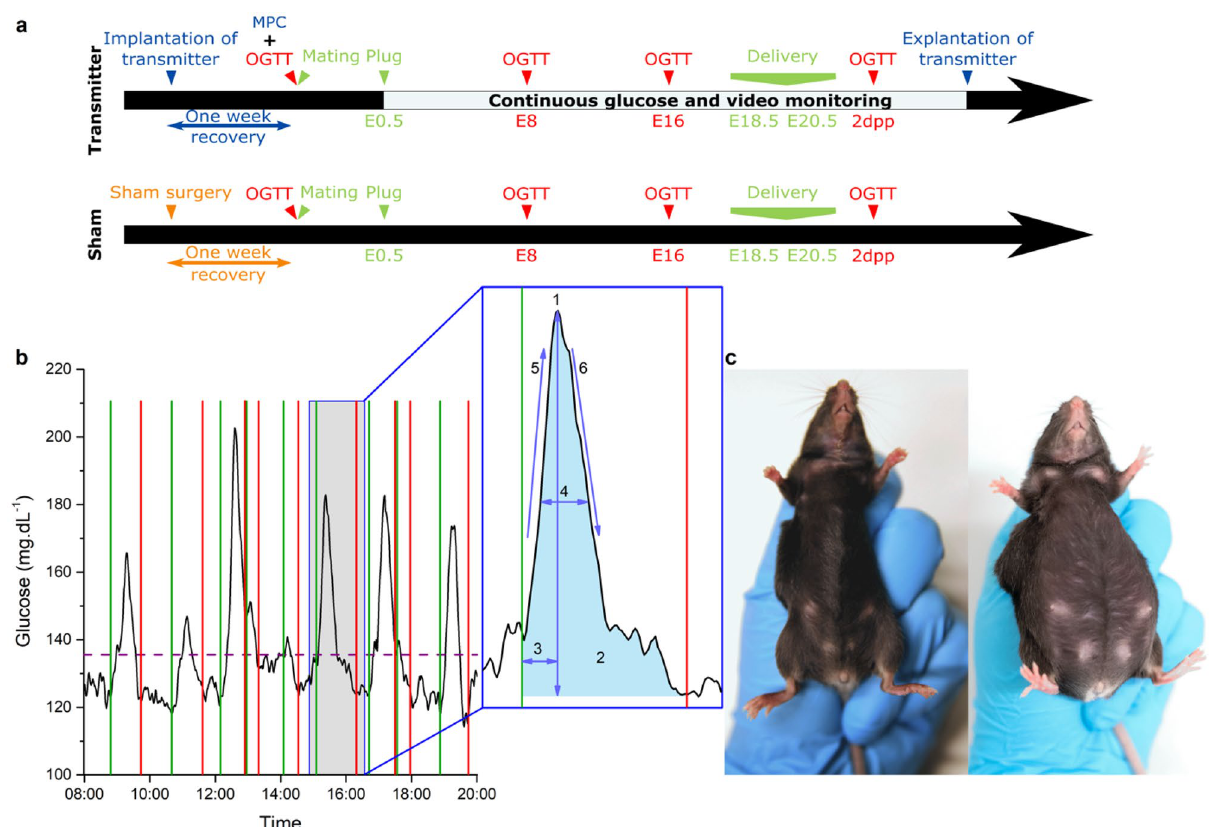
Figure 1. Overview of the experimental setup. ( a ): Study design of the transmitter and sham group. Multipoint calibration (MPC), Oral glucose tolerance test (OGTT). ( b ) Example trace of glucose excursions and the analysed parameters. Green line: start of the glucose excursion. Red line: end of the glucose excursion. Purple dashed line: threshold for peak detection at 20% of the normalised maximal peak value. Insert: 1: Mean amplitude of glucose excursion (MAGE) in mg.dL −1 , 2: Incremental area under the curve (iAUC) in s.mg.dL −1 , 3: Time to peak in minutes, 4: Full width at half maximum (FWHM) in minutes, 5: Glucose uptake in mg.dL −1 .s −1 , 6 : Glucose clearance in mg.dL −1 .s −1 . ( c ) Pictures of an implanted mouse. Left: before pregnancy, right: during pregnancy (photo: Frone